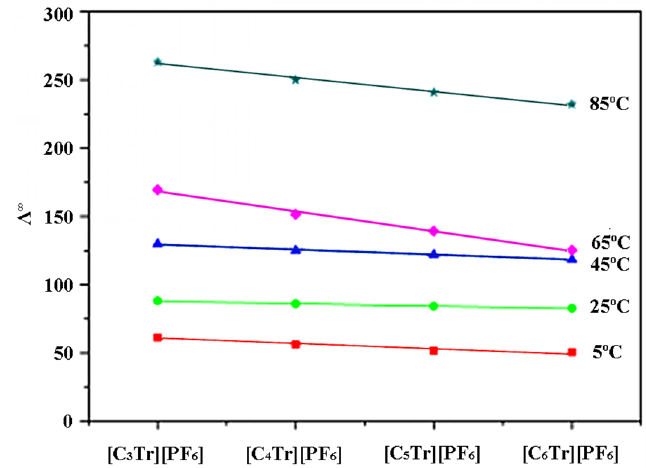
Figure 2. Linear fitting between limiting molar conductivity ( Λ ∞ ) and alkyl length on IL cations.